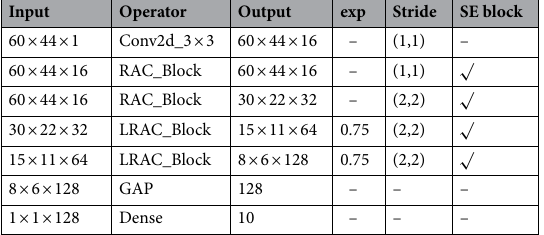
Table 1. The overall architecture of RACNN. “exp” represents the scaling ratio of the number of output channels of the first RAC module in the LRAC